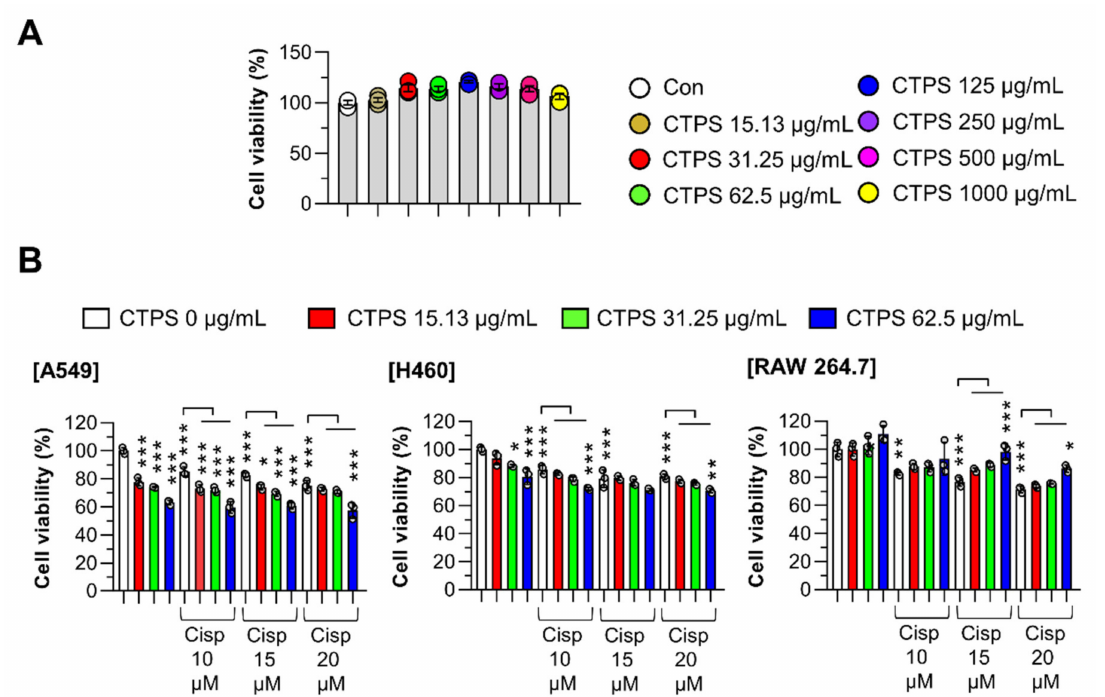
Figure 1. Effects of CTPS on the proliferation and viability of cisp-treated macrophages. ( A ) Cell viability after CTPS treatment with various doses (0, 15.625, 31.25, 62.5, 125, 250, 500, and 1000 µ g/mL) for 24 h in RAW264.7 cells. ( B ) After CTPS pretreatment for 2 h with various doses (15.625, 31.25, and 62.5 µ g/mL), the cell proliferation was analyzed in the presence of cisp (0, 10, 15, and 20 µ M) for 24 h. The data are expressed as the mean ± standard deviation ( n = 3). * p < 0.05, ** p < 0.01 or *** p < 0.001. CON: untreated cells; CTPS, Cudrania tricuspidata -derived polysaccharides;